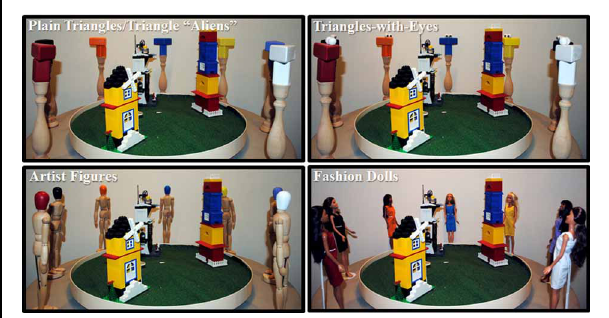
FIGURE 2 | Example of one of the three buildings displays showing the different target conditions used in the Experiments: upper left (Experiments 1 and 3), upper right (Experiment 1), lower left and right (Experiment